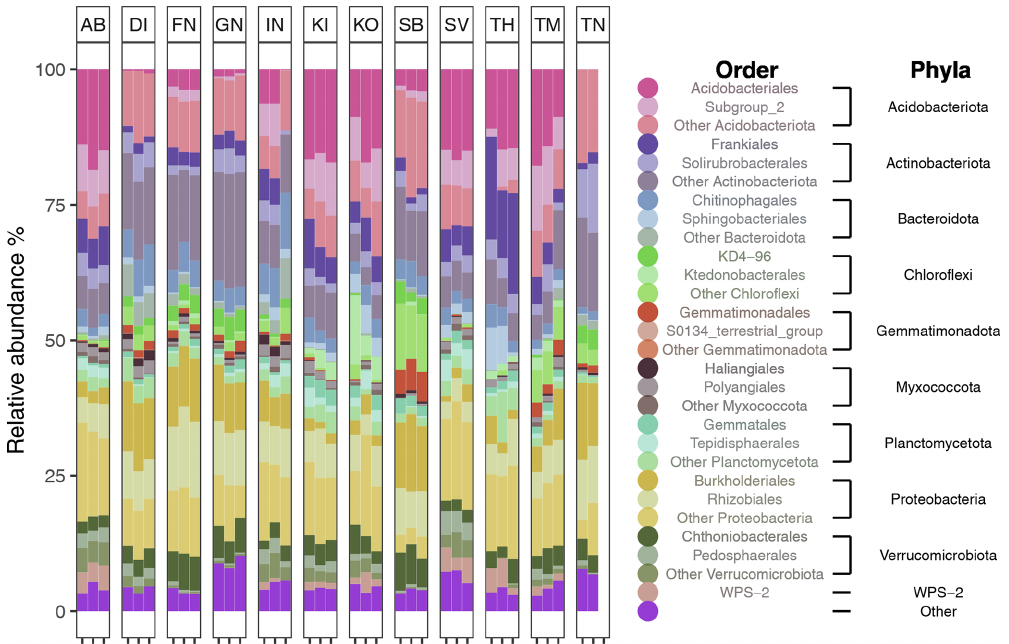
Figure 3. Bar plot showing the relative abundance (%) of the top 10 most abundance phyla across all soil samples. Color shades indicate the two most abundant orders for each of these